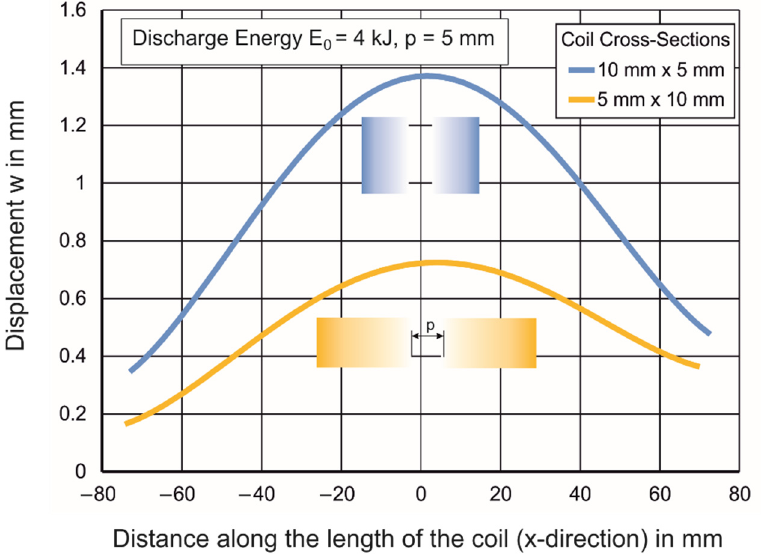
Figure 14. Experimentally measured displacement of the coils in the y-direction for two different coil cross-sections.